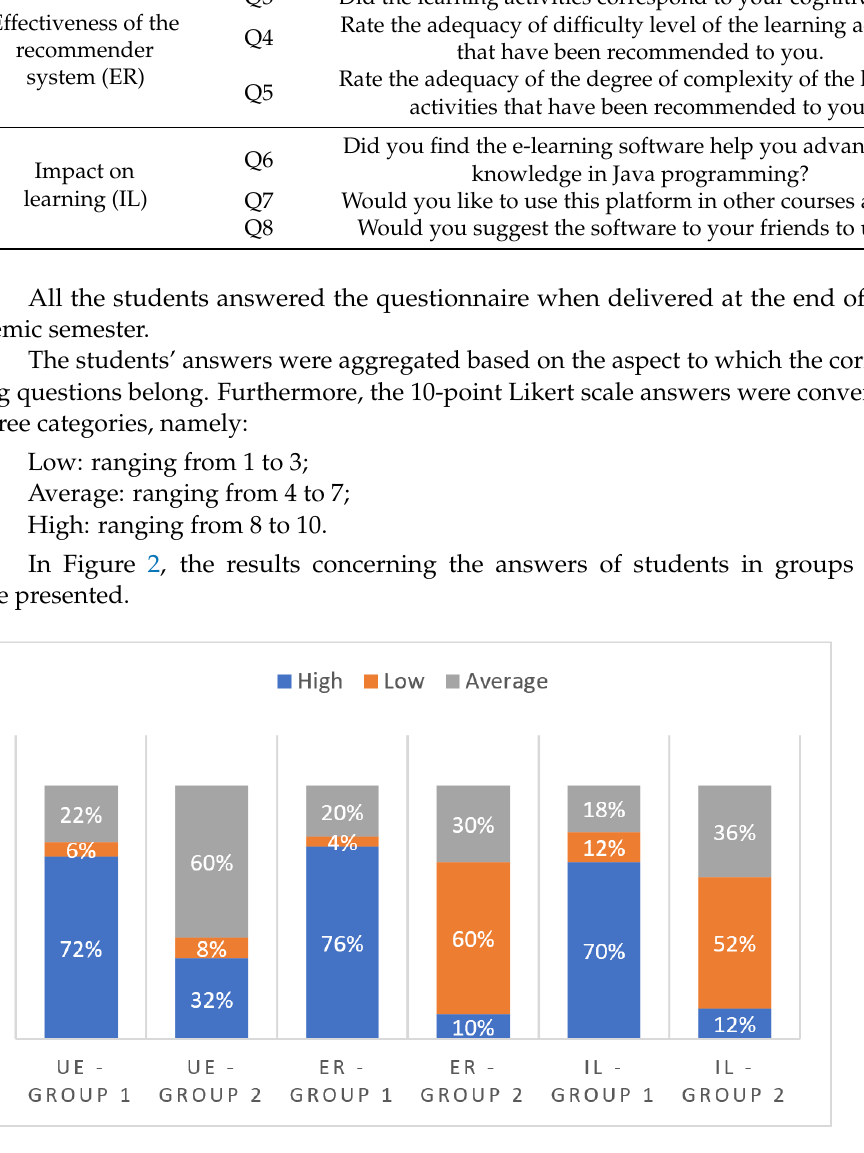
Figure 2. Questionnaire results.